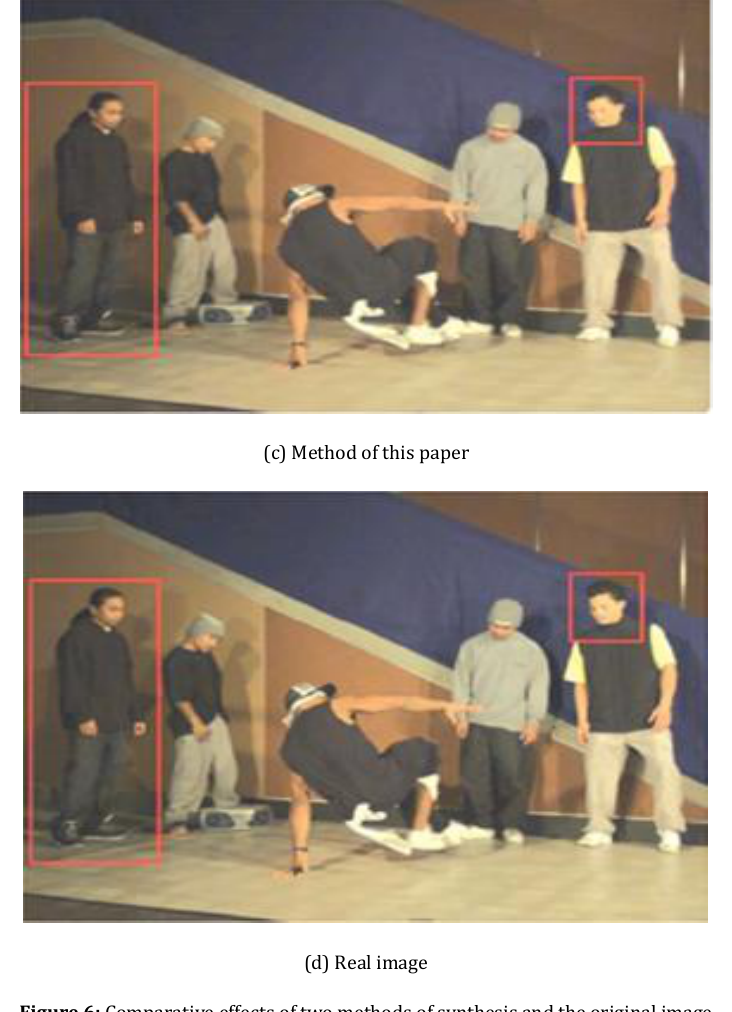
Figure 6: Comparative effects of two methods of synthesis and the original